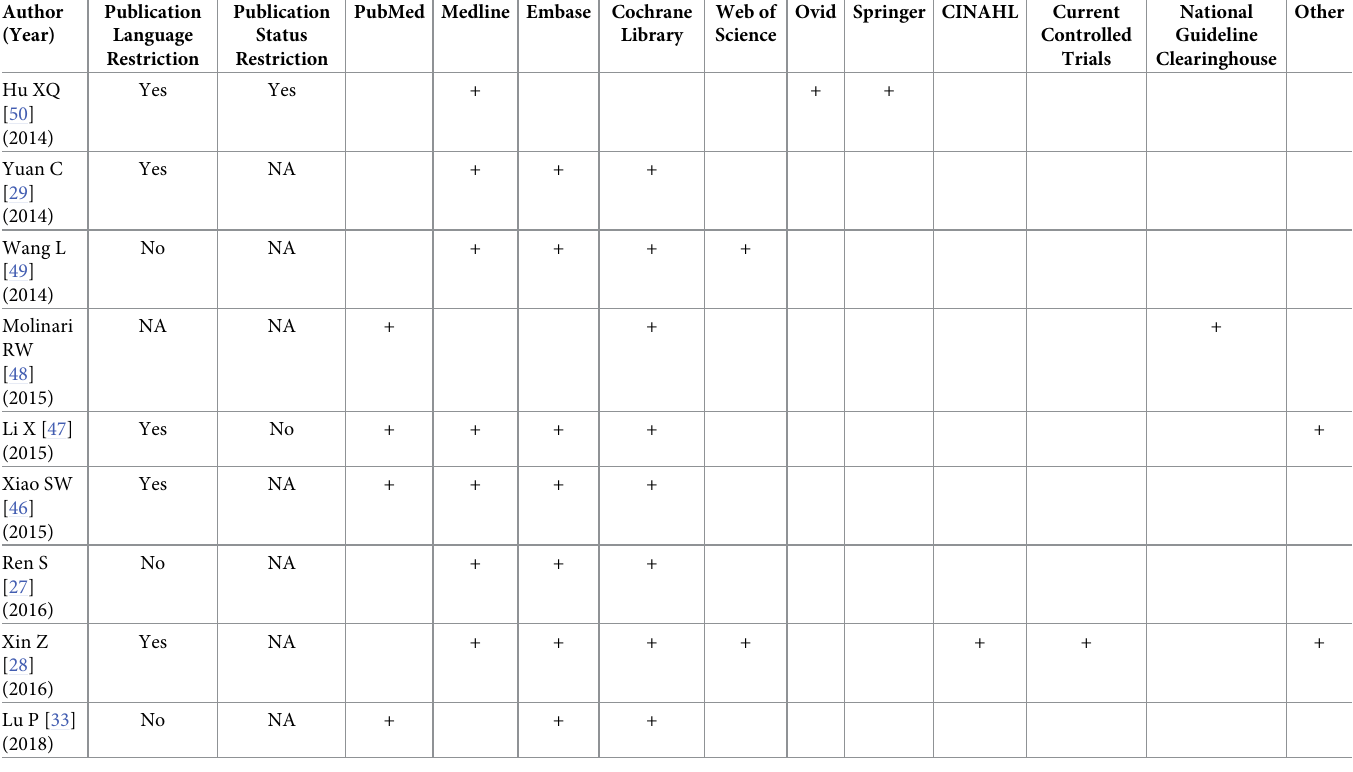
Table 3. Search methodology used by each